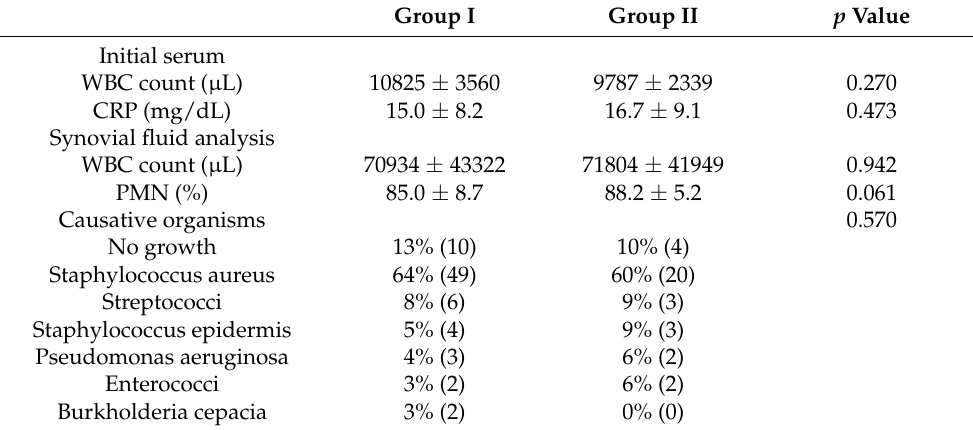
Table 2. Laboratory results by study